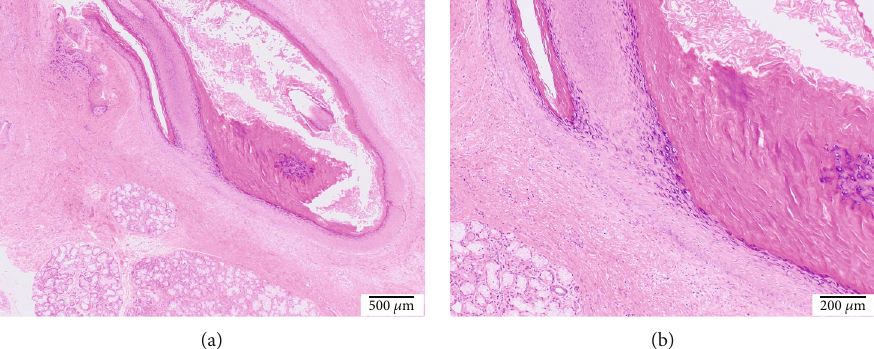
Figure 3: Histopathological fi ndings of the lip cyst. (a) Hematoxylin and eosin stain × 4. (b) Hematoxylin and eosin stain × 100. A cyst covered with keratinized strati fi ed squamous epithelium. Keratin is stored in the cyst.